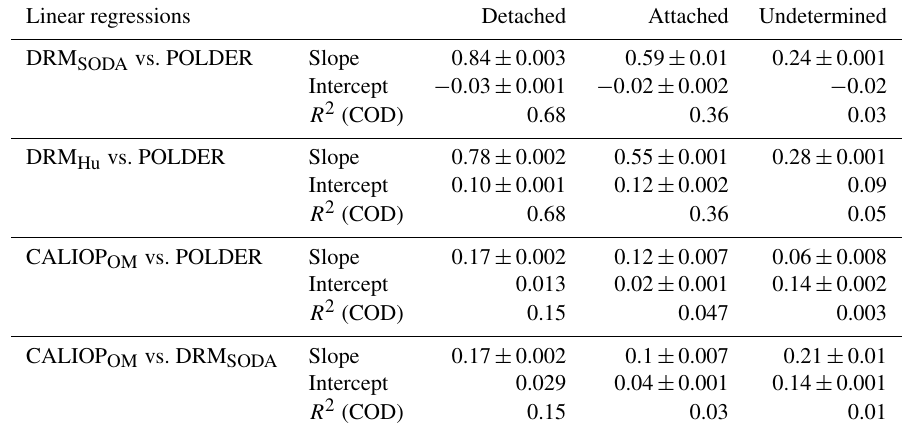
Table 7. Linear regressions calculated between different methods for data acquired over June 2006 to December 2010, on a global scale above the ocean in the case of aerosol attached to the cloud top, detached from the cloud and undetermined situations for AOT smaller than